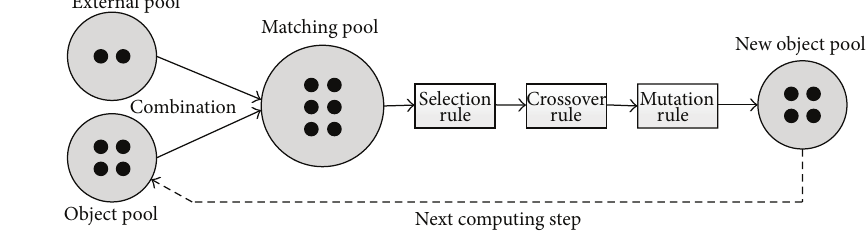
Figure 2: Evolution procedure of objects in a cell.